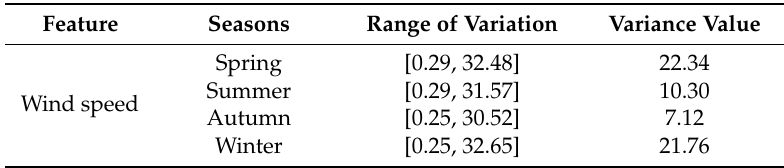
Table 10. The statistical indicators of wind speed in different